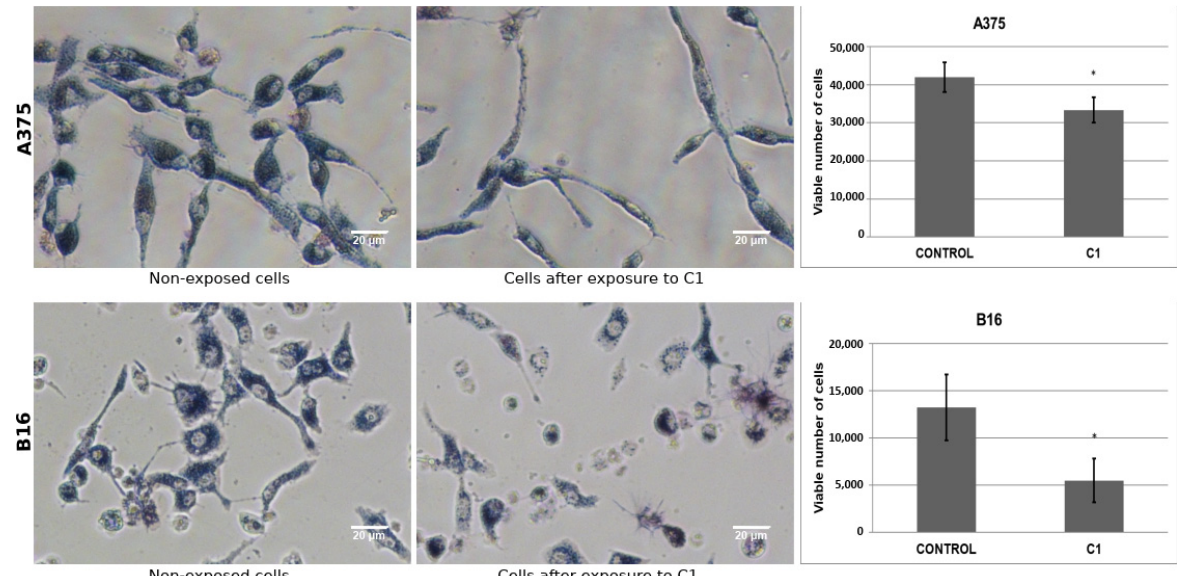
Figure 6. Effect of compound C1 on human and mouse melanoma cell lines. Human (A375, upper panels) and mouse (B16, lower panels) melanoma cells were seeded into a 48-well plate overnight and treated with C1 for 48 h. Cell viability was determined by MTT reductase activity (photographs) and trypan blue (TB) exclusion assay (bar graphs) after exposure to hit compound C1 (shown here at a concentration of 11 µ g/mL for human cells and 2.75 µ g/mL for mouse cells). * Statistically